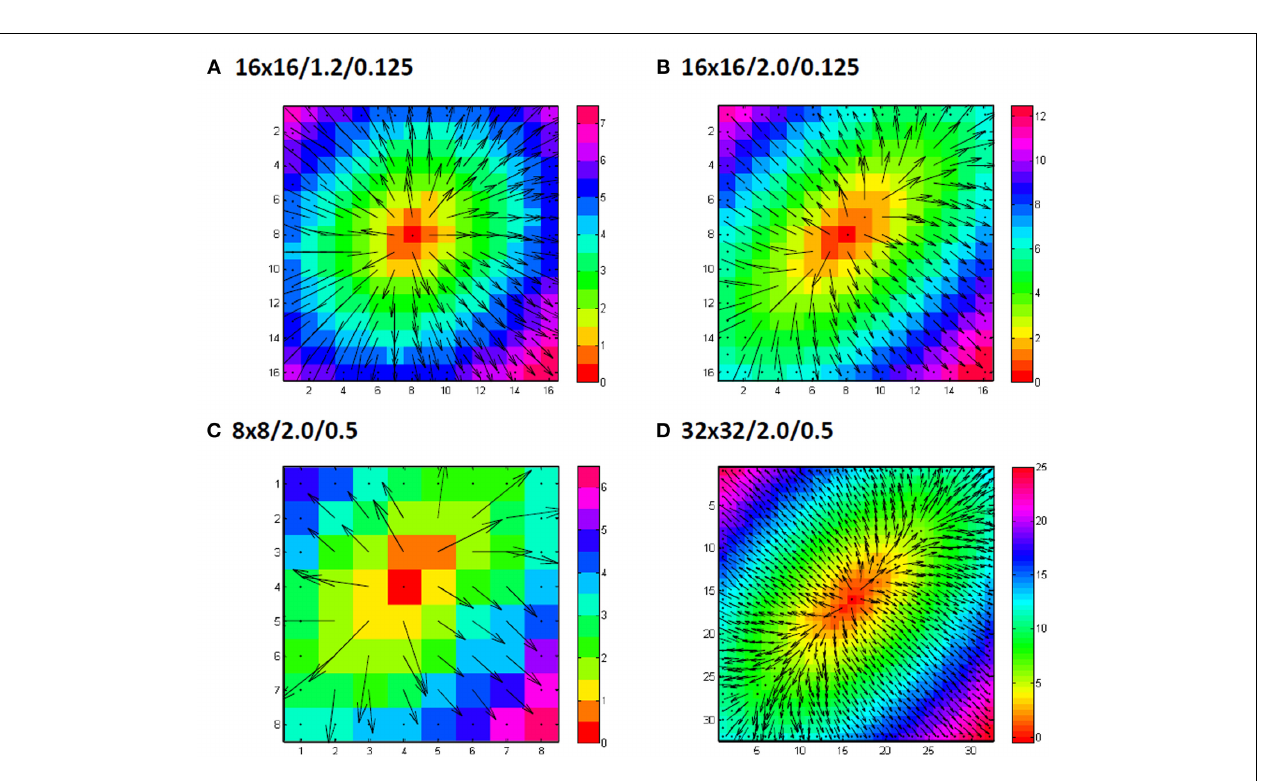
activation times. Panel (B) shows another example, this time for a anisotropy ratio of 2 (0.9m/s longitudinal, 0.45m/s transversal). Panel (C) shows a simulation for a smaller grid (8 by 8) and panel (D) for a larger grid (32 by 32). In (C) and (D) also the simulated noise is larger with a standard deviation of